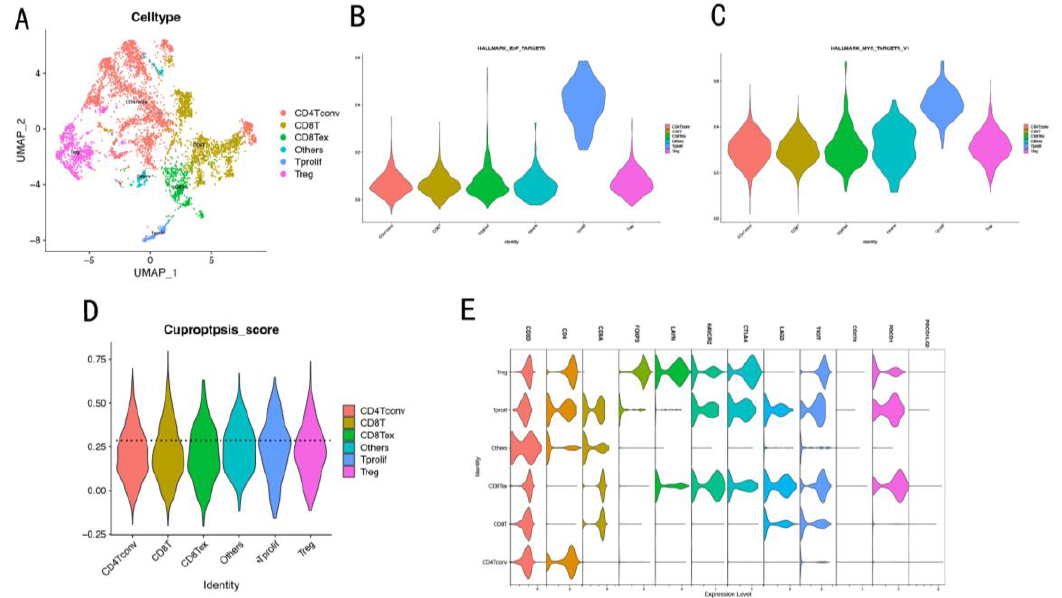
Figure 8. Tprolif cells associated with cuproptosis in the HCC were obtained based on scRNA-seq. ( A ) UMAP diagram shows the T cell subtypes of the patients. Each cluster is color-coded according to the cell type, and the cluster annotations are shown in the figure. ( B , C ) E2F and MYC target V1 pathways are significantly enriched in the Tprolif subgroup based on the hallmark gene set using the GSVA.( D ) Scores of CRGs in T cell subsets. ( E ) Violin diagram shows the expression characteristics of 12 marker genes in T cell subtypes.